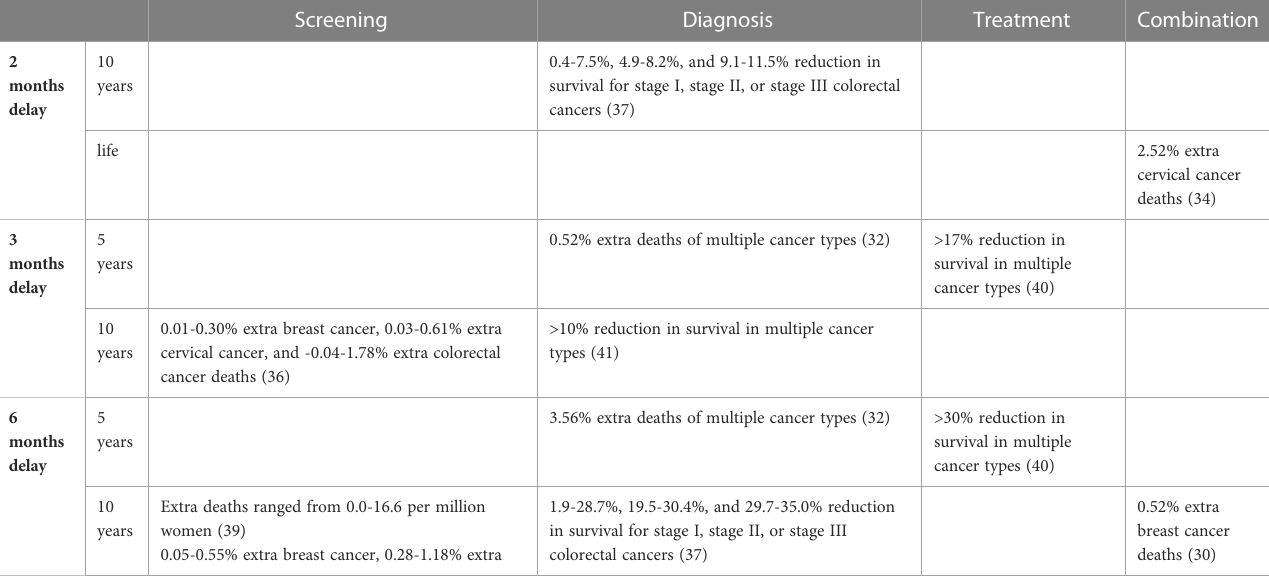
TABLE 3 Effect of the Covid-19 induced delays on survival speci fi ed per type of delay.